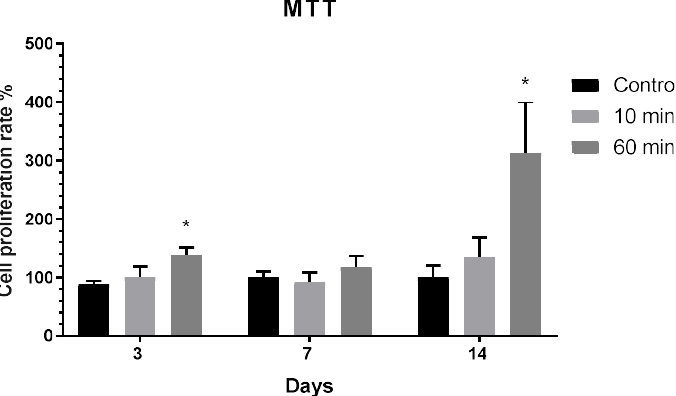
Figure 11. hFOB cell proliferation on samples modified at di ff erent times determined by mitochondrial activity after several days in a culture. Results are the mean of four independent experiments performed in the DCD ± S.D. A one-way ANOVA was performed between the O.D. of each modified sample and the unmodified sample or control, where (*) ( p < 0.05).